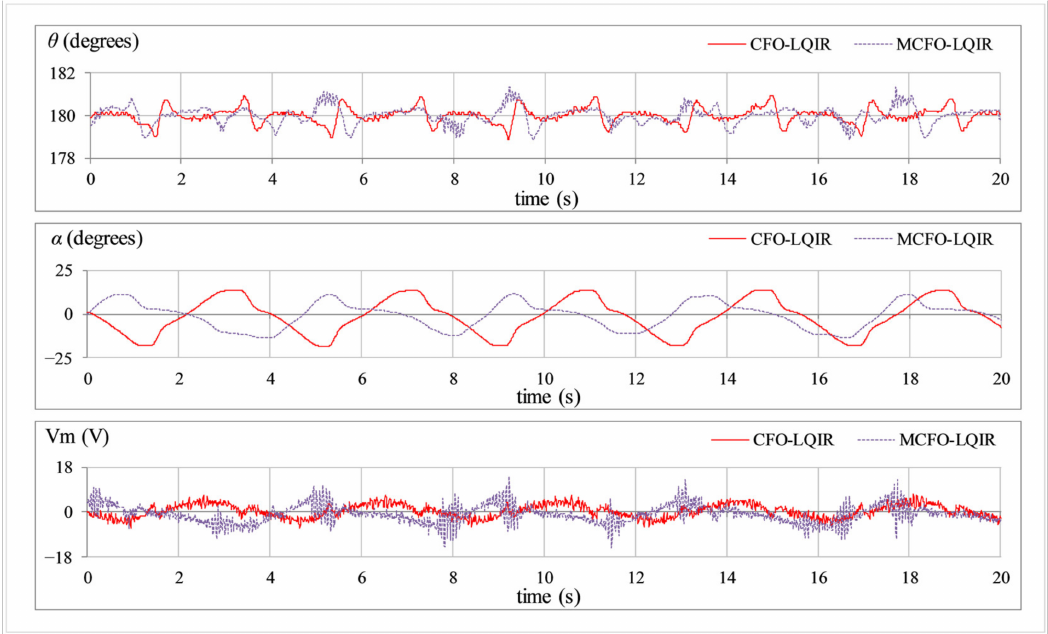
Figure 9. Response of CFO-LQIR versus MCFO-LQIR under nominal